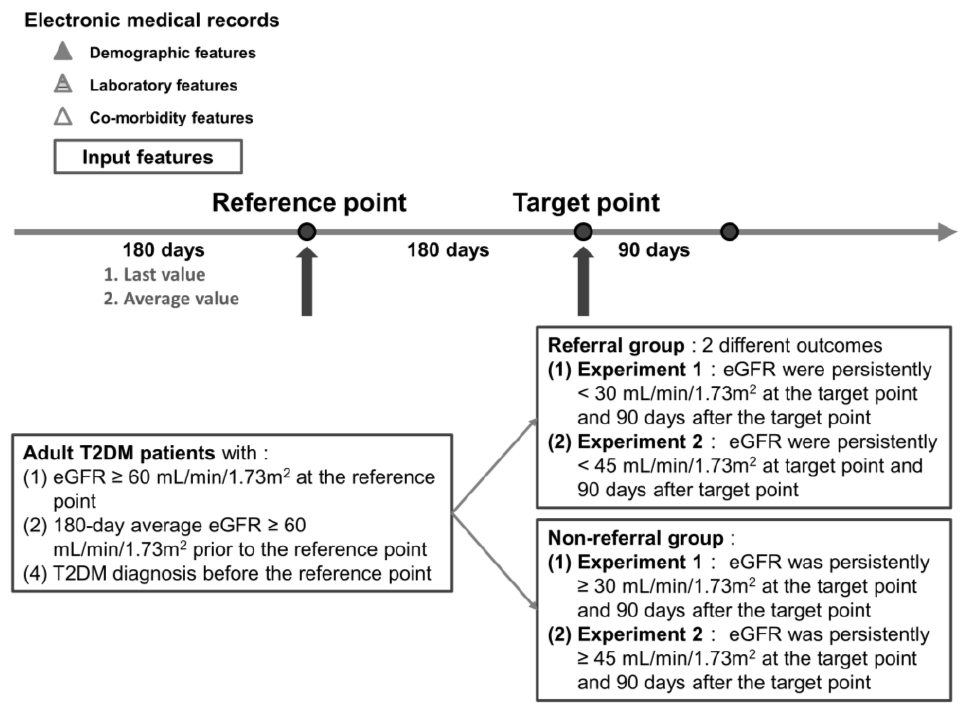
Figure 1. Time frame of our study design and label definition.